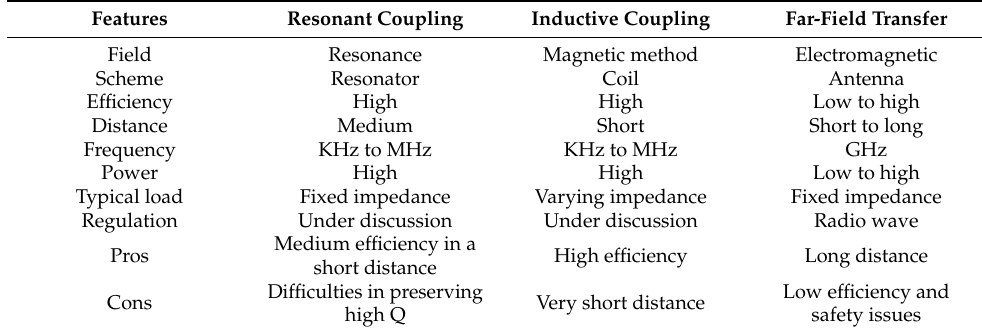
Table 2. Power transmission characteristics